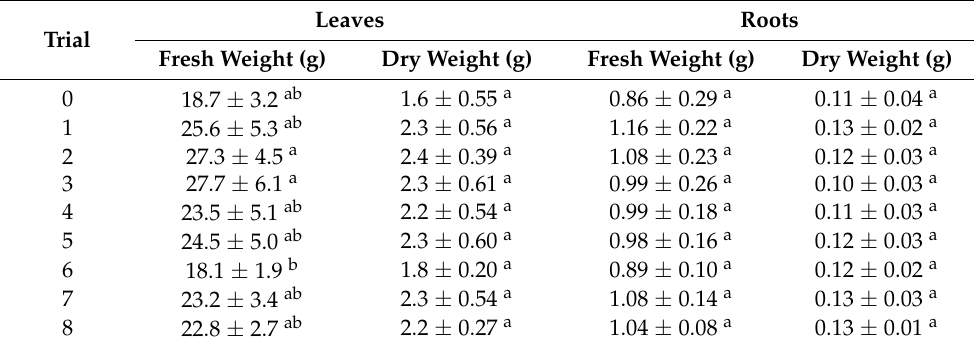
Table 2. Fresh and dry weight of spinach leaves and roots (mean value ± standard deviation) 1 cultivated in trials 0–8.